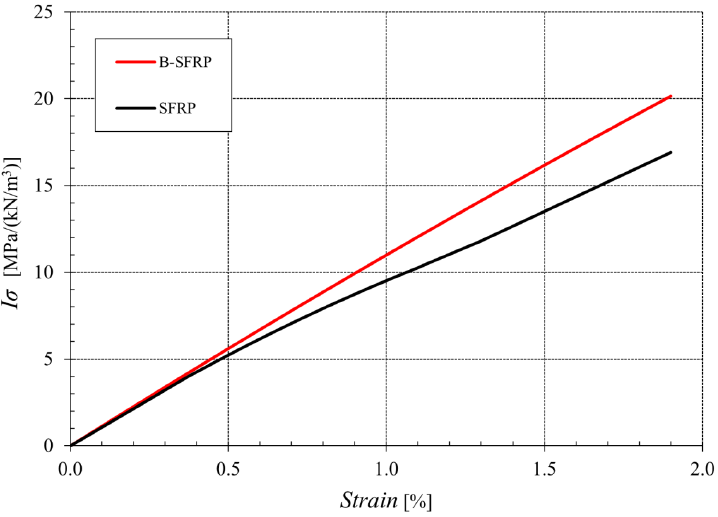
Figure 8. Specific tensile curves of the examined biocomposites SFRP and B-SFRP (without